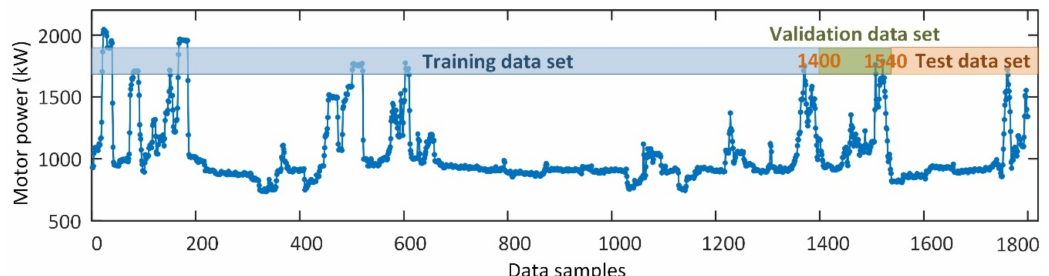
Figure 4. The division of training dataset, validation dataset, and test